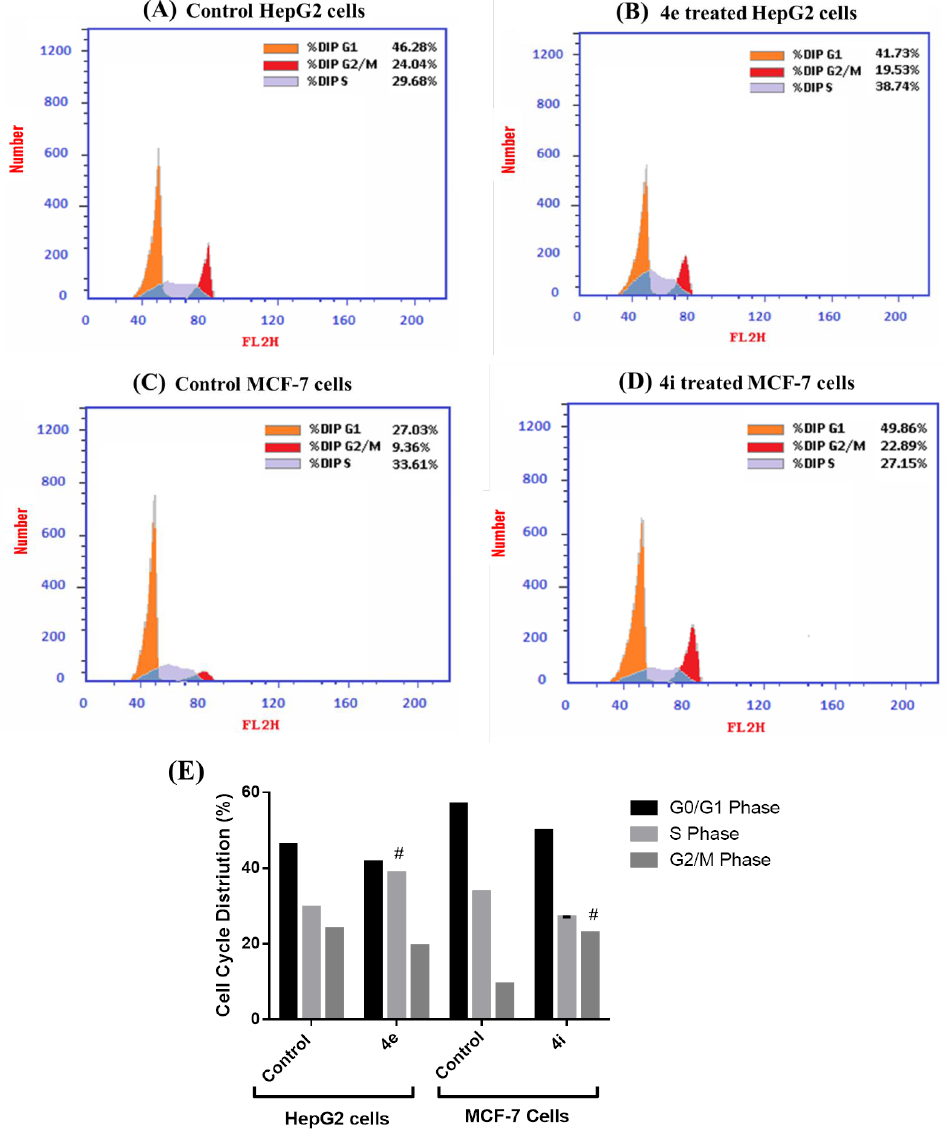
Figure 6. The cell cycle analysis using flow cytometry in HepG2 and MCF-7 cells. The representative histogram of the G0/G1, S, and G2/M phases of the gated cells for ( A ) control HepG2 cells; ( B ) 4e treated HepG2 cells; ( C ) control MCF-7 cells; and ( D ) 4i treated MCF-7 cells. ( E ) The percentage of cell cycle distribution: each sample ’ s cell distribution was quantitatively examined using at least 10,000 cells per sample. Within a single experiment, data are presented as the mean standard